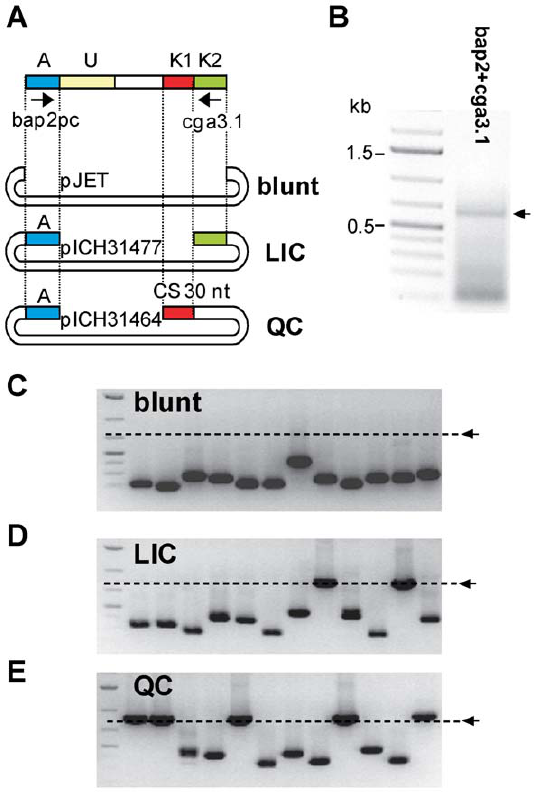
Figure 7. Comparison of blunt-end cloning, ligation-indepen- dent cloning and QC cloning on sample T044. ( A ) To compare the efficiency of the three cloning methods, a PCR product amplified from G-tailed cDNA prepared from sample T044 was cloned using blunt-end, LIC and QC cloning (A, adaptor; U, unknown sequence; K, known sequence; ns, non-specific; CS, catching sequence). ( B ) PCR product amplified from T044 G-tailed cDNA using primers bap2 pc and cga3.1. ( C, D, E ) 12 randomly picked clones for each cloning strategy were analyzed by colony PCR using vector primers. The size of the expected immunoglobulin fragment is indicated by an arrow and a dashed line.